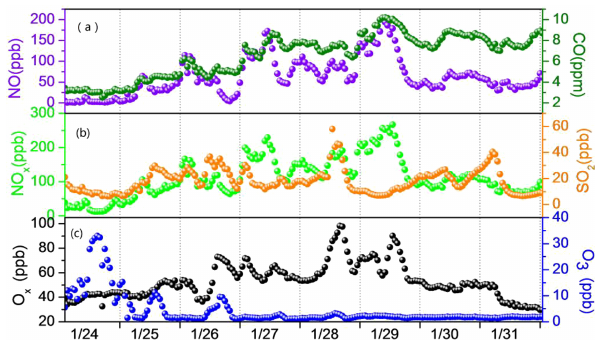
Figure 9. Mixing ratios of (a) NO and CO, (b) NO x and SO 2 , (c) O x and O 3